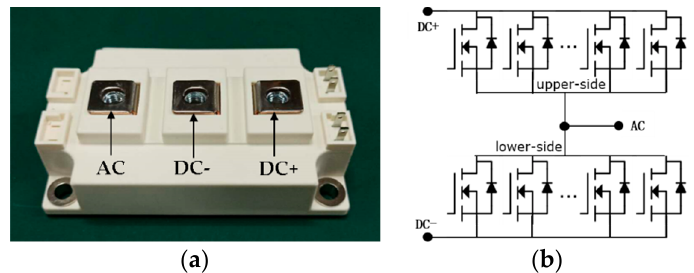
Figure 1. Outline and circuit topology of the developed silicon carbide (SiC) high-power module: ( a ) standard 62 mm package outline, ( b ) circuit topology of half-bridge configuration.